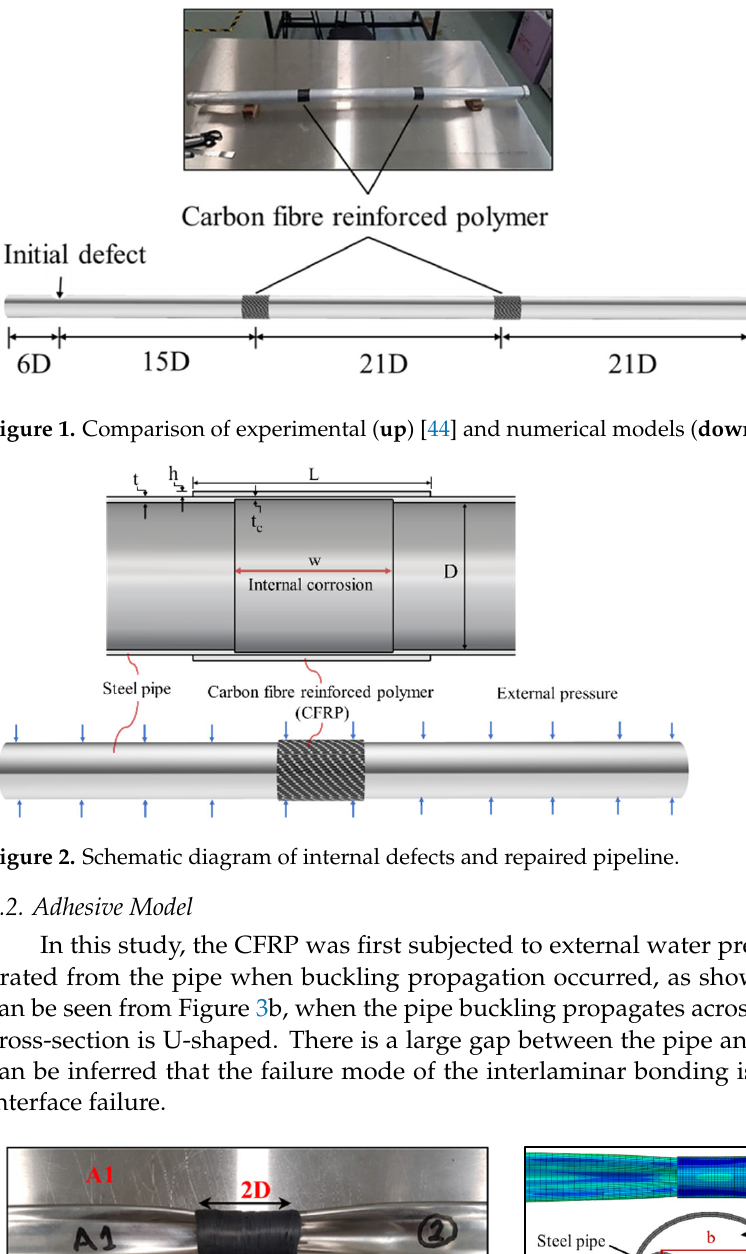
Figure 2. Schematic diagram of internal defects and repaired pipeline.